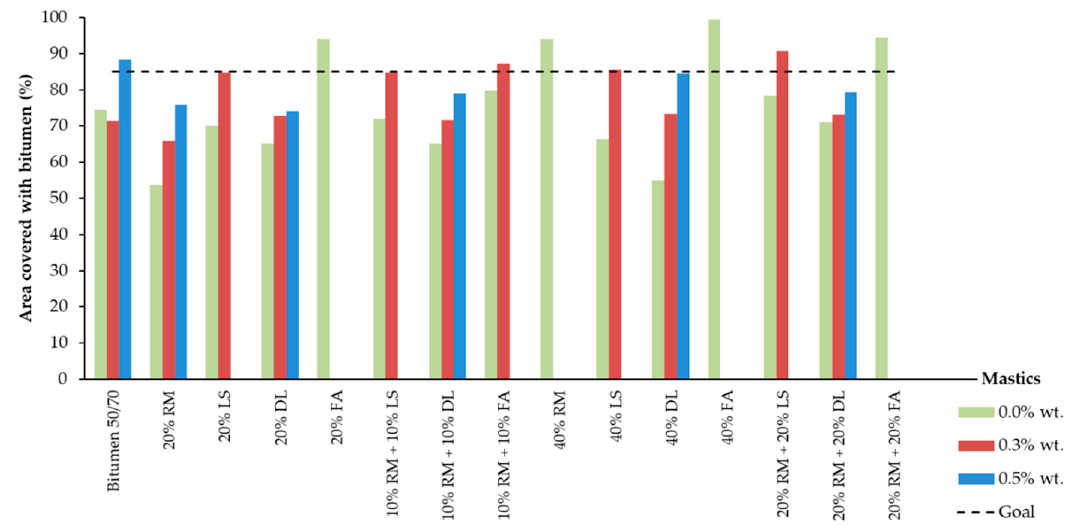
Figure 7. Covered area of aggregates after adhesiveness test (with and without